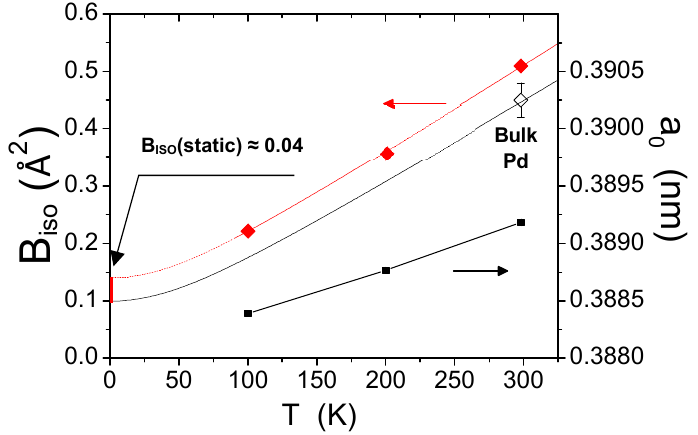
Figure 6. WPPM results. Lognormal distribution of cube edges, D ( a ) and microstrain distribution along three crystallographic directions: [100] (black), [110] (red), [111] (green) ( b ).